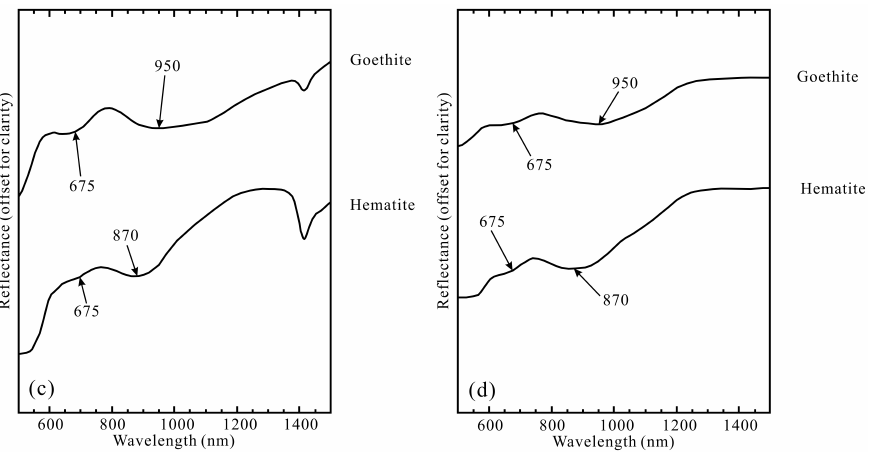
Figure 5. ( a – d ) Spectral curves of the investigated alteration minerals (500–2500 nm): ( a , c ) spectral curves of the alteration minerals measured from the drill cores of the Baiyanghe uranium deposit; and ( b , d ) spectral curves from the reference spectral library of the United States Geological Survey (USGS).